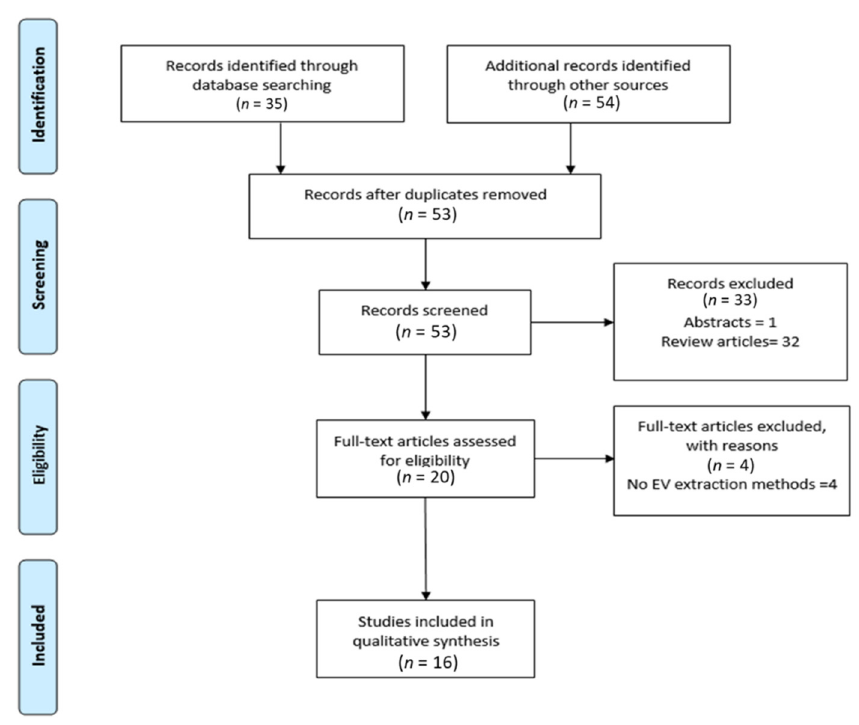
Figure 2. Flow chart demonstrating the application of the Preferred Reporting Items for Systematic Reviews and Meta-Analyses (PRISMA).